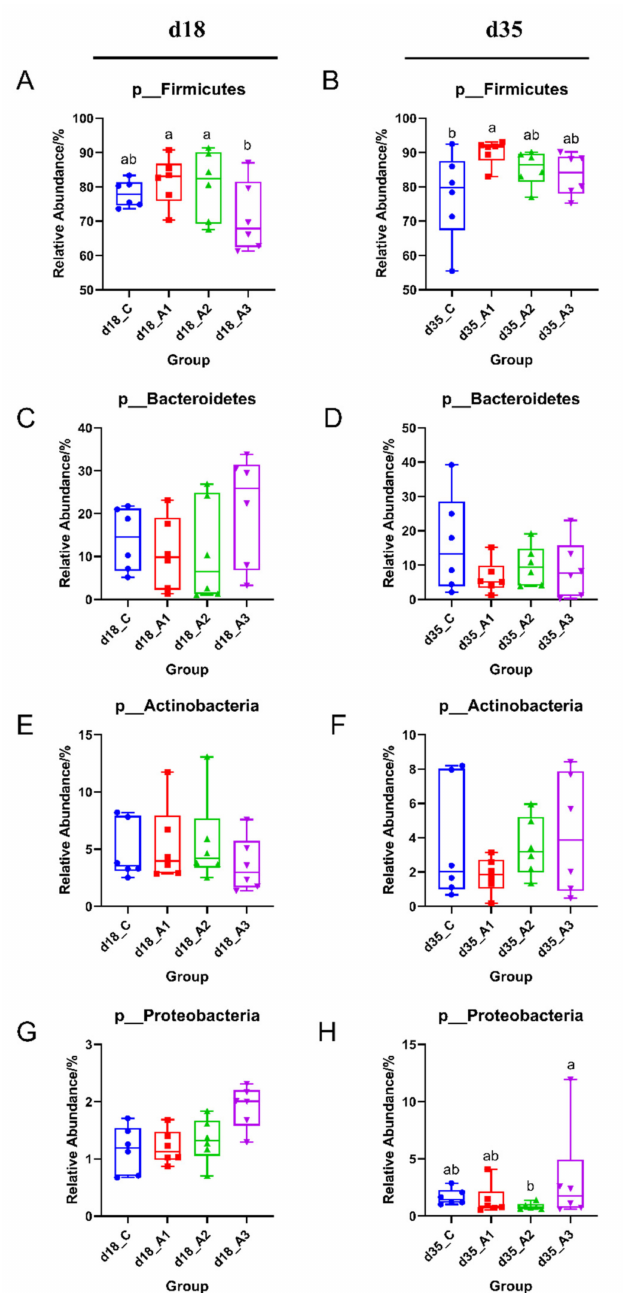
Figure 3. Comparison of dominant intestinal flora at the phylum level. Relative abundances of Firmicutes ( A ), Bacteroidetes ( C ), Actinobacteria ( E ), and Proteobacteria ( G ) among the four groups on d 18. Relative abundances of Firmicutes ( B ), Bacteroidetes ( D ), Actinobacteria ( F ), and Proteobacteria ( H ) among the four groups on d 35. Labeled means with different superscript letters are significantly different, p < 0.05. Mean values are based on six pigs (six pigs per